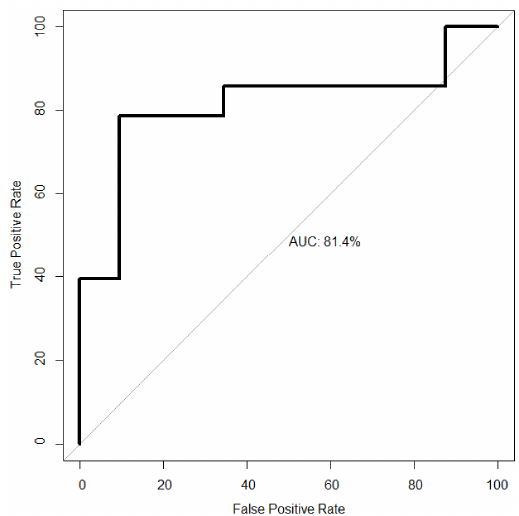
Figure 7. ROC curve and AUC statistics.